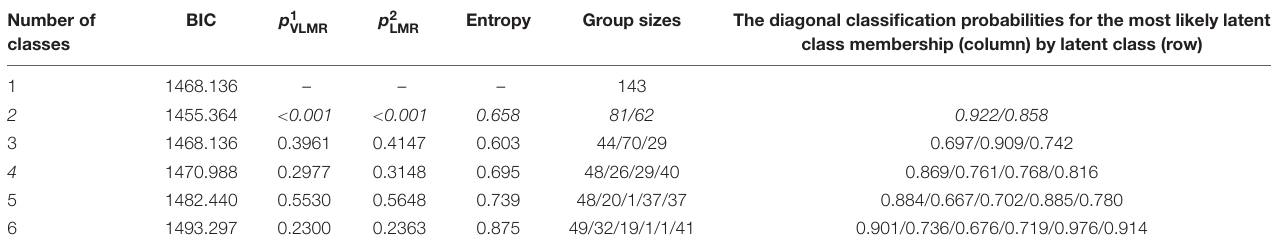
TABLE 2 | Information criteria values for the tested Latent Profile Analysis (LPA)